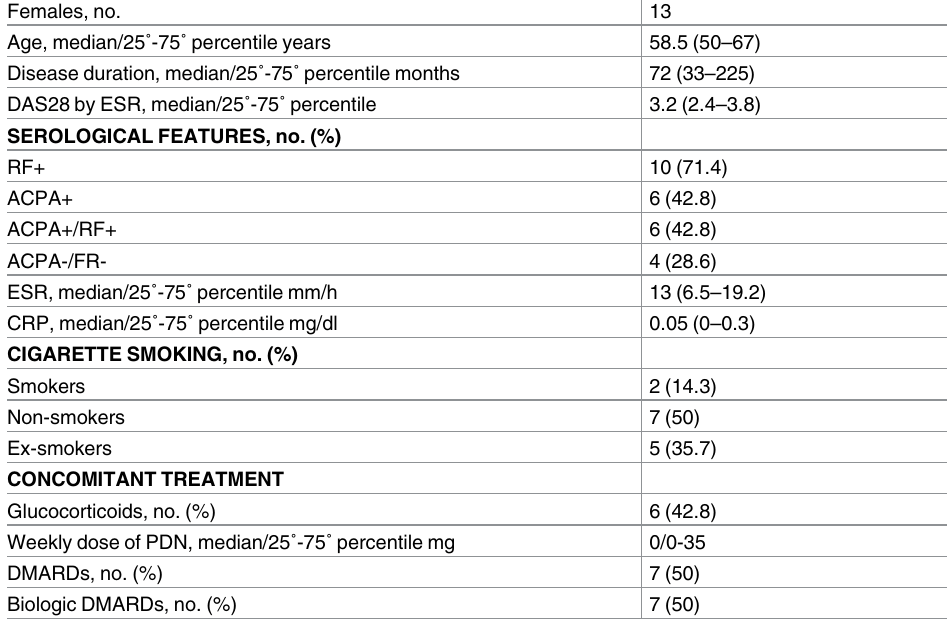
CONCOMITANT TREATMENT Glucocorticoids, no. (%) 6 (42.8) Weekly dose of PDN, median/25˚-75˚ percentile mg 0/0-35 DMARDs, no. (%) 7 (50) Biologic DMARDs, no. (%) 7 (50) DAS28 = disease activity score; ESR = erythrocyte sedimentation rate; RF = rheumatoid factor; ACPA = anticitrullinated protein antibody; CRP = C-reactive protein; PDN = prednisone; DMARDs = disease-modifying antirheumatic